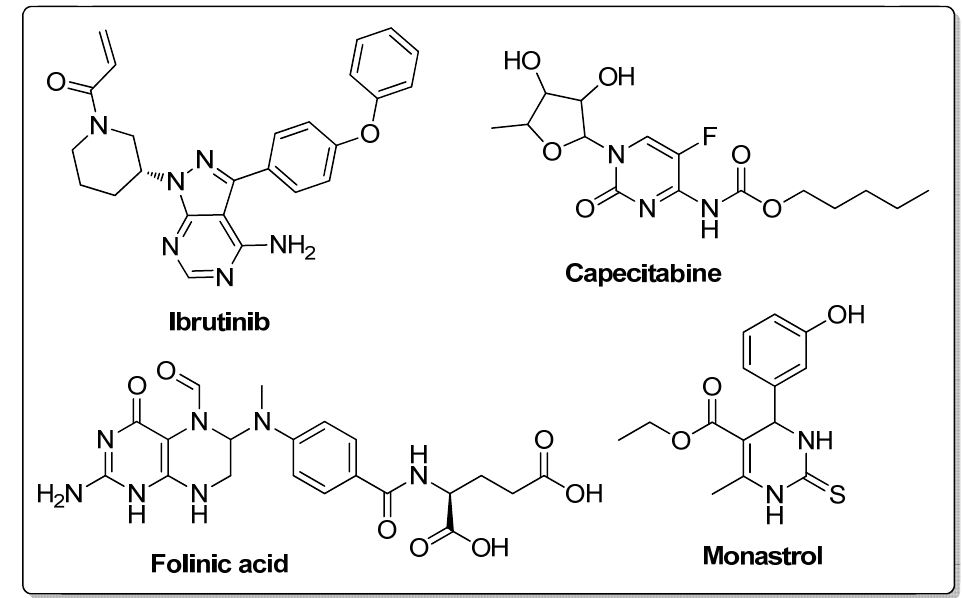
Figure 48. Pyrimidine and pyrimidinone clinical drugs.